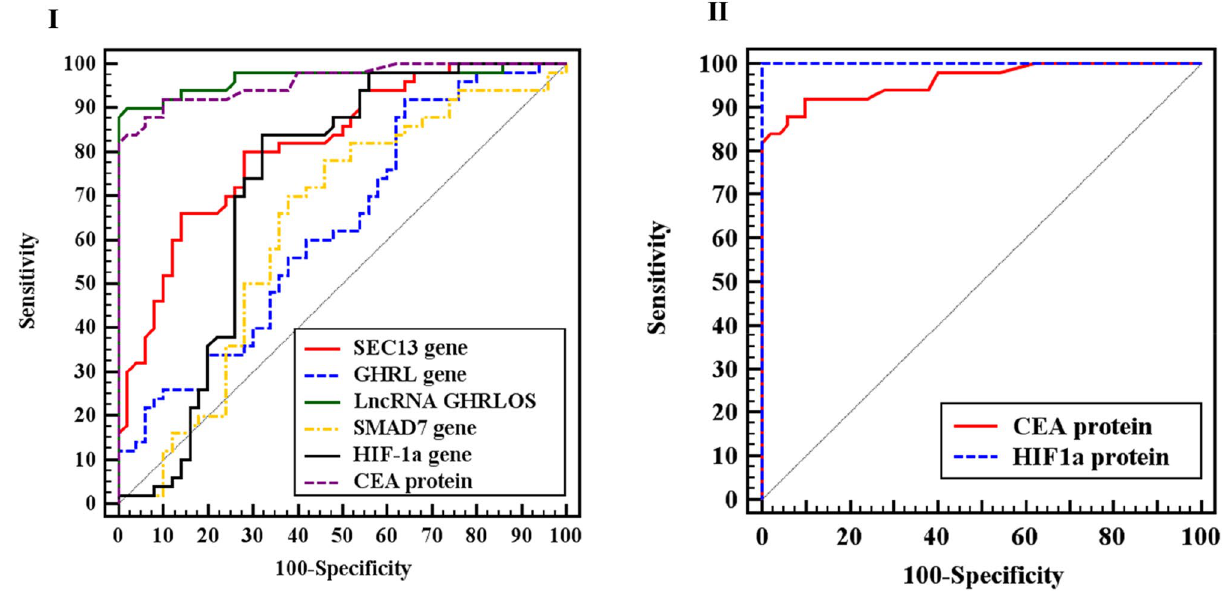
Figure 2. ROC curve for (I) SEC13, GHRL, lncRNA GHRLOS, SMAD7, HIF-1α genes and serum CEA, (II) serum HIF-1α and